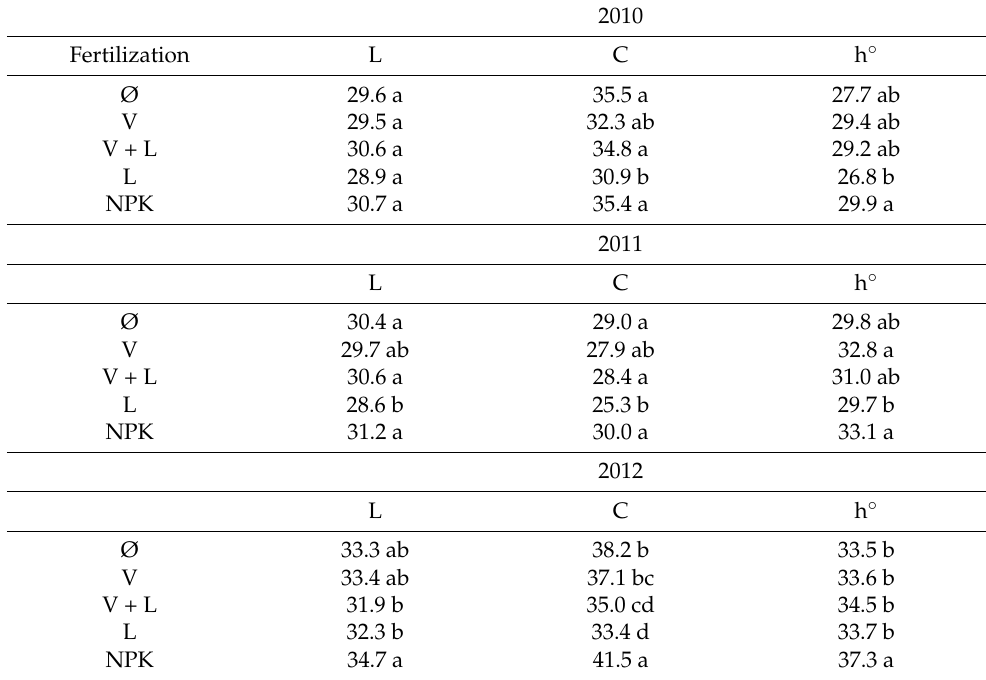
Table 4. Strawberry fruit color parameters (L, lightness; C, chromaticity; h ◦ , intensity of red color). Fertilization L